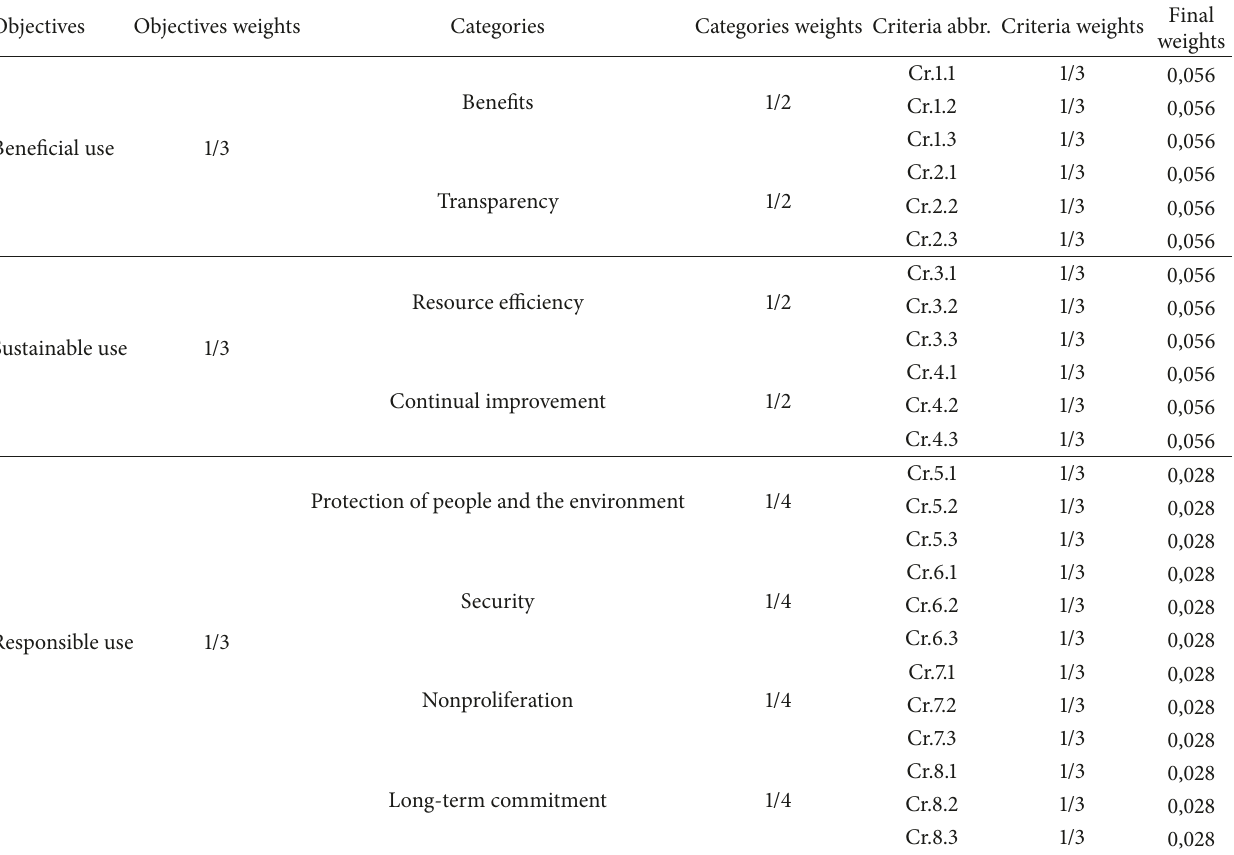
Table 8: Base-case weights option (“equal